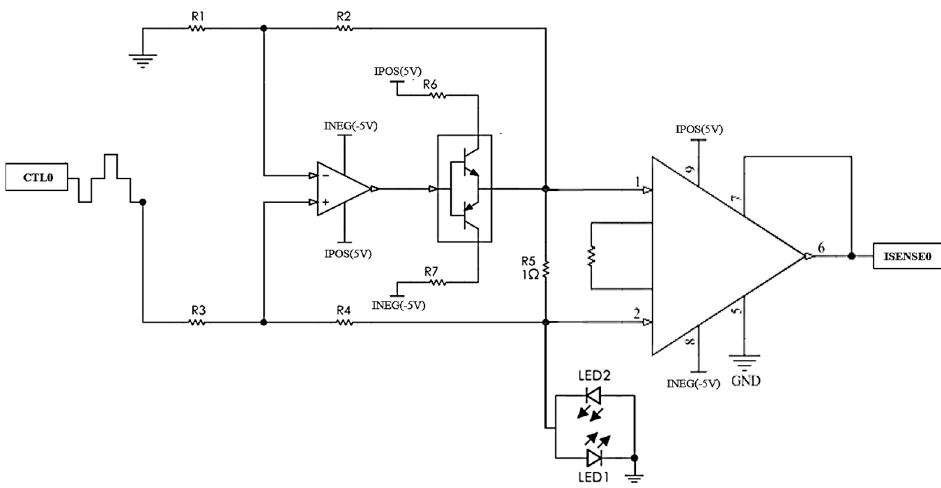
Figure 3. Current source schematic design.